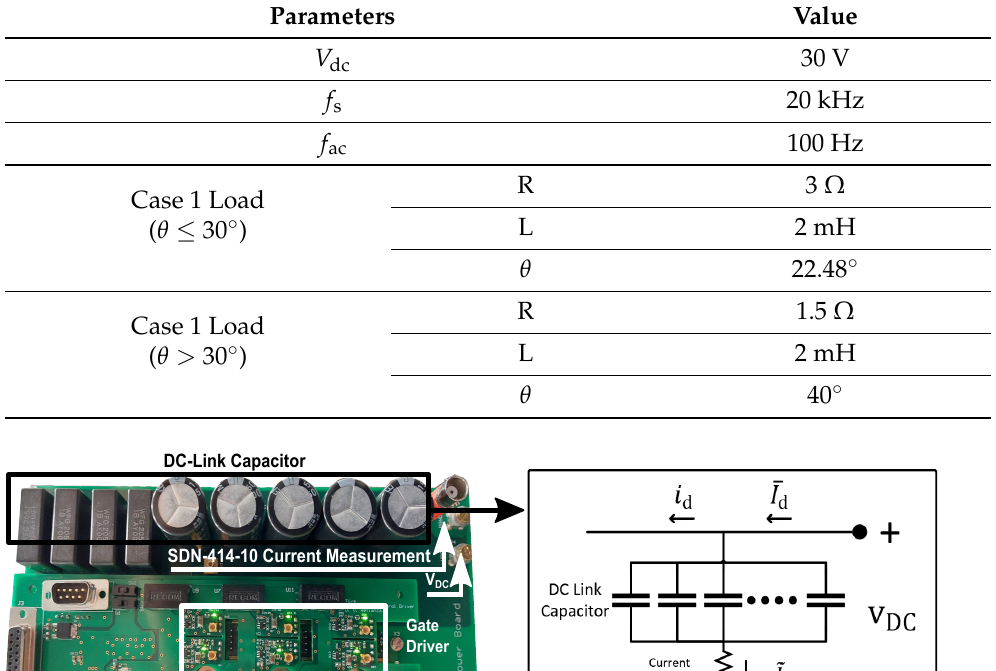
Table 3. System parameters of the three-phase VSI used for experiments.